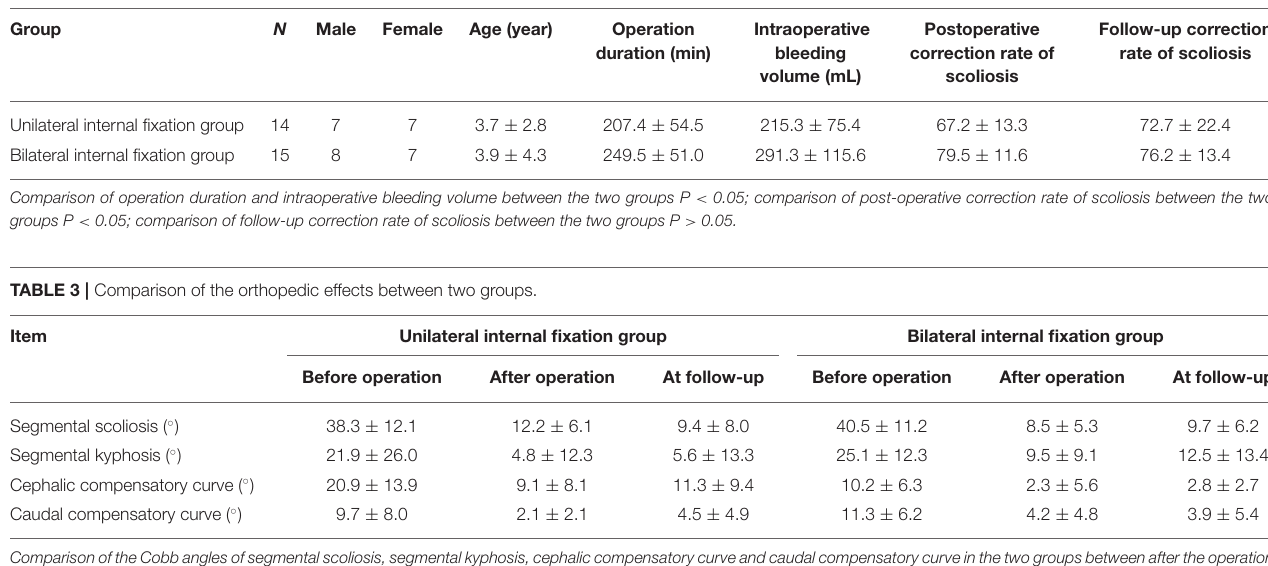
ComparisonoftheCobbanglesofsegmentalscoliosis,segmentalkyphosis,cephaliccompensatorycurveandcaudalcompensatorycurveinthetwogroupsbetweenaftertheoperation and at the last follow-up with those before the operation P < 0.05; comparison of scoliosis and kyphosis before the operation between the two groups P > 0.05; comparison of scoliosis and kyphosis at the last follow-up between the two groups P > 0.05.